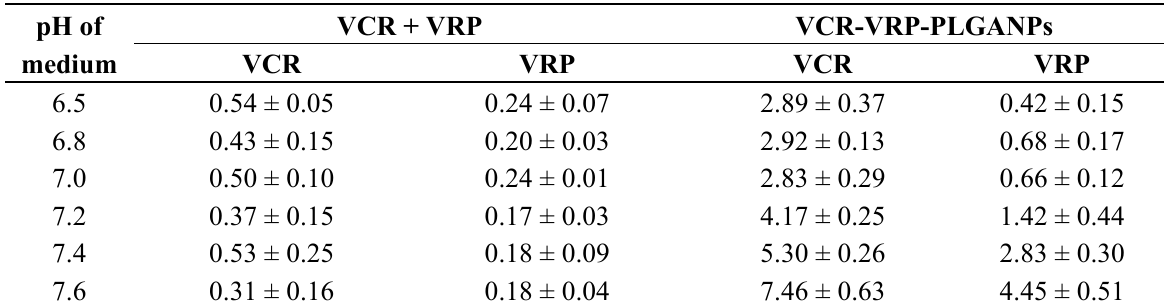
Table 3. The T 0.5 values of VCR and VRP in vitro release calculated according to the Weibull formula. pH of